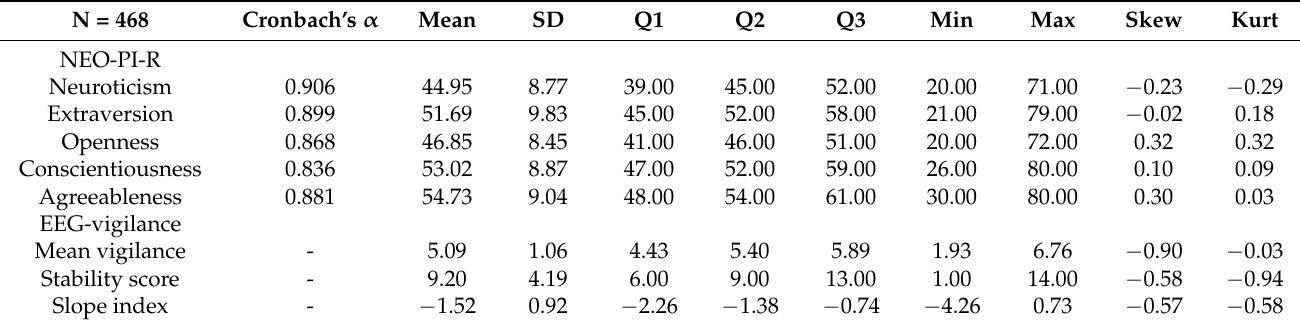
Table 1. Descriptive statistics of NEO-PI-R scores and VIGALL 2.1 variables of EEG-vigilance. N =